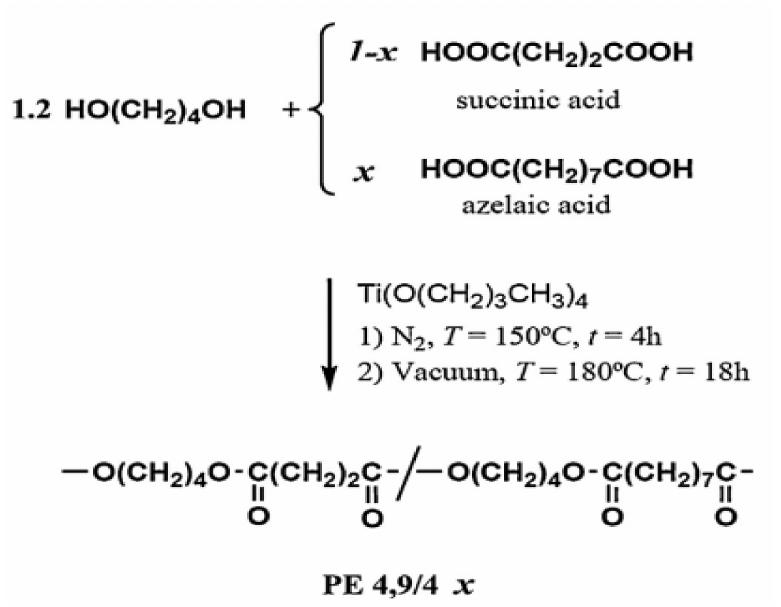
Figure 8. Synthesis of poly(butylene azelate-co-butylene succinate) copolymers [56]. Adapted with permission from Park et al. (1998).